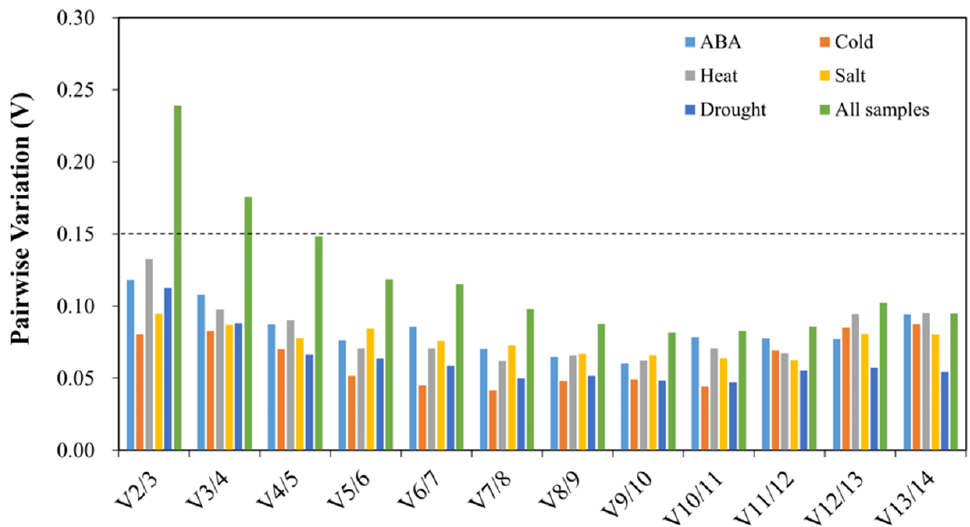
Figure 3. Pairwise variation (V) of fourteen candidate reference genes. Dashed lines represent the threshold (0.15).